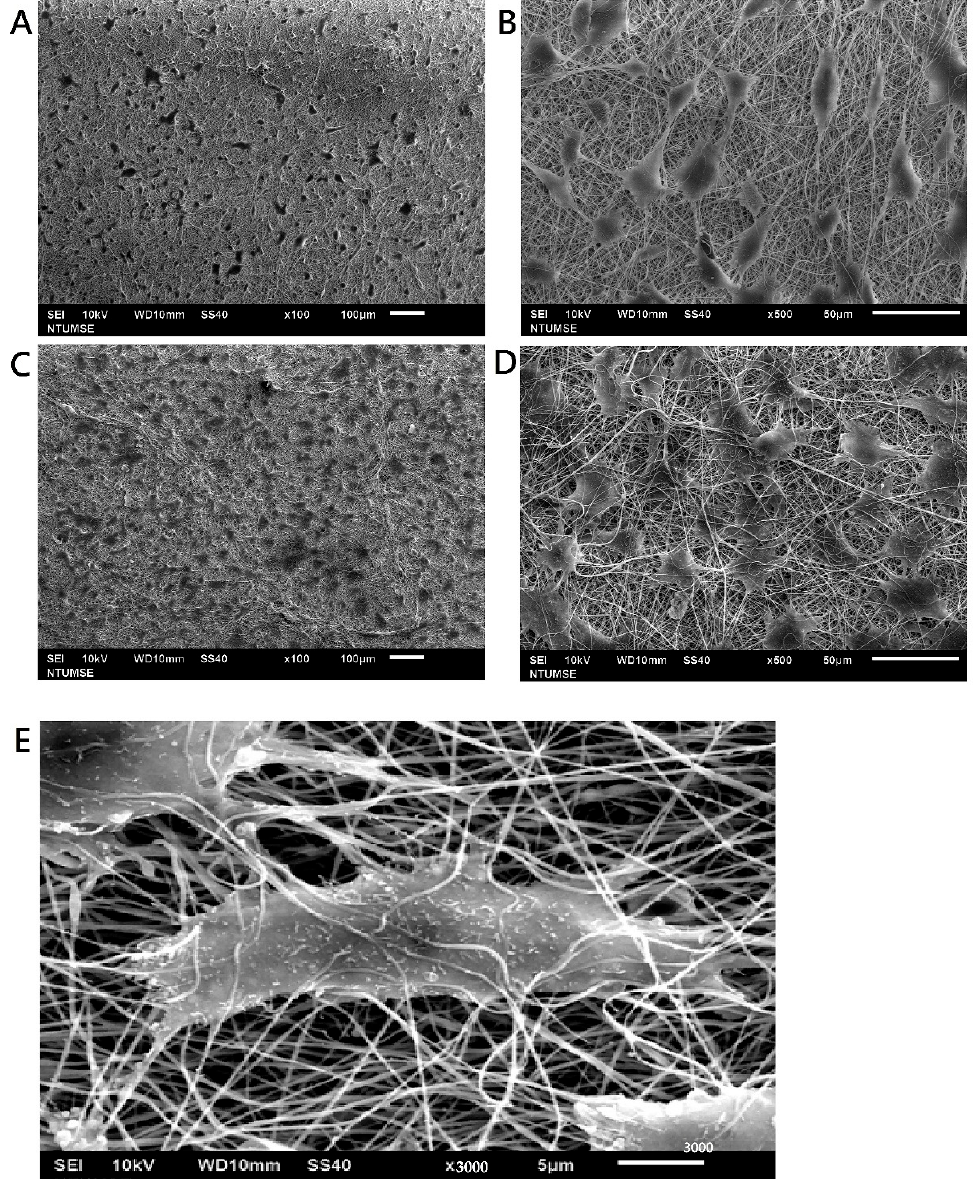
Figure 7. SEM images of primary porcine AF cell morphology on fibroin/gelatin electrospun mem- brane: ( A ) 24 h, 100×; ( B ) 24 h, 500×; ( C ) 72 h, 100×; ( D ) 72 h, 500×; ( E ) 72 h, 3000×.